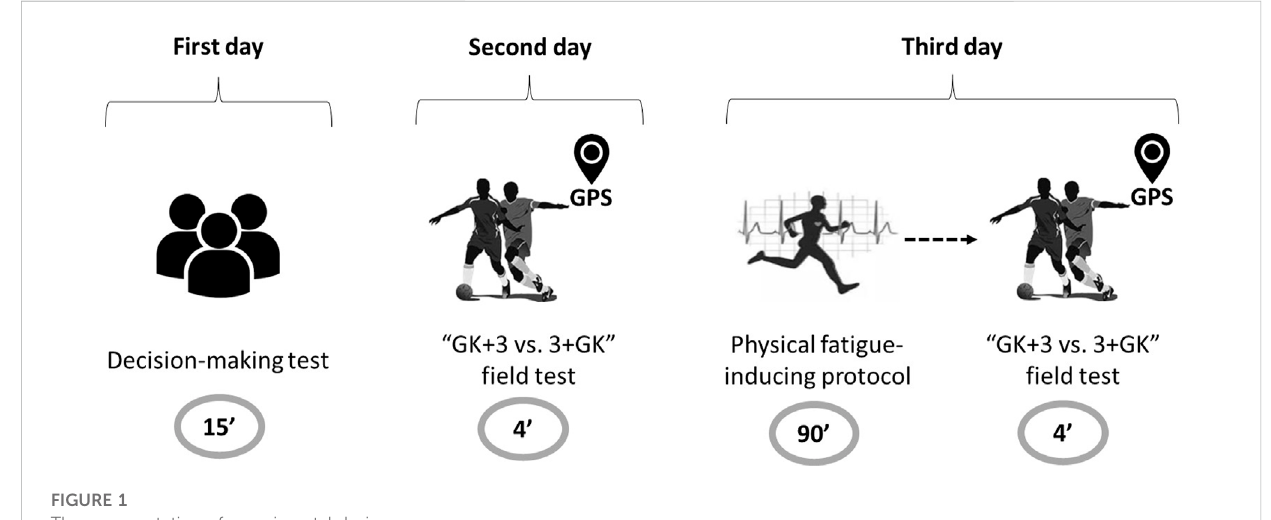
FIGURE 1 The representation of experimental